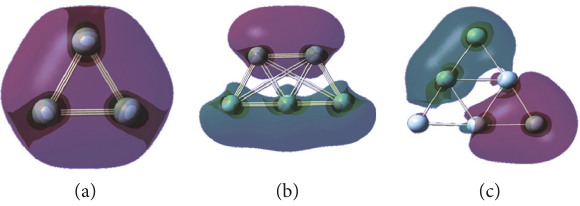
Figure 7: HOMO surfaces of clusters of (a) 3 silver atoms, (b) 5 silver atoms, and (c) 6 silver